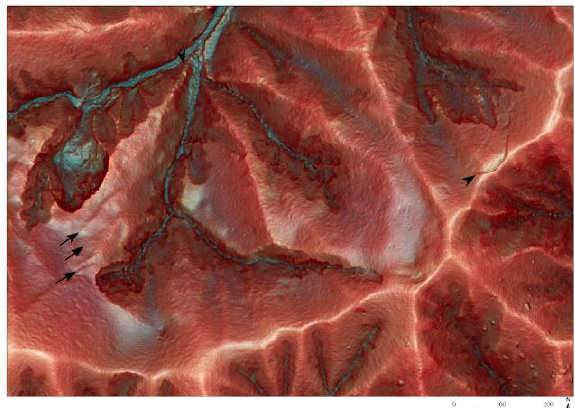
Figure 10.A RRIM from 1 m mesh DEM from Airborne